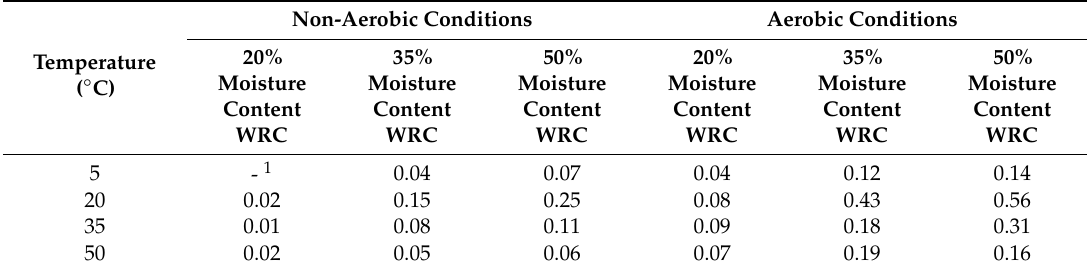
Table 2. Measured dry matter losses of WRC chips after storage test